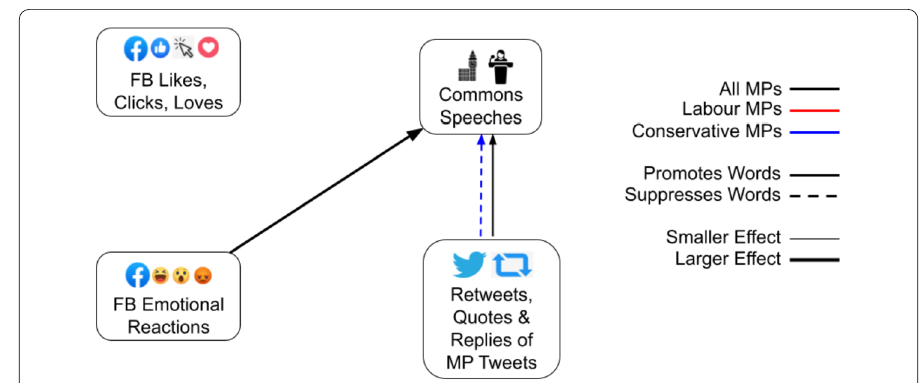
Figure 7 Marginal change in word transfer to Commons Speeches associated with different kinds of interactions. Lines indicate statistically significant measurements. Colors indicate the party of the MPs for whom we’re measuring a response. Line thickness is proportional to the log of the measured effect. See Table 2 for precise magnitudes, p -values, an 95% confidence intervals